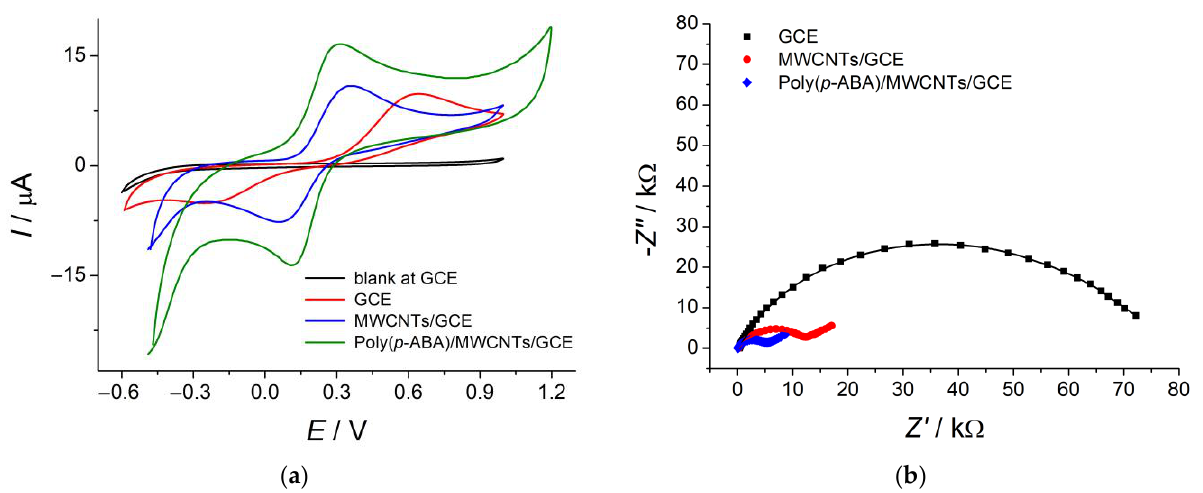
Figure 5. ( a ) Cyclic voltammograms of 1.0 mM ferrocyanide ions in 0.1 M KCl at the bare GCE, MWCNTs/GCE, and poly( p -ABA)/MWCNTs/GCE. The potential scan rate is 100 mV s ‒1 ; ( b ) Nyquist plot (experimental (points) and fitted (lines)) for bare GCE, MWCNTs/GCE, and poly( p - ABA)/MWCNTs/GCE in the presence of 1.0 mM mixture of ferro-/ferricyanide ions in 0.1 M KCl. Polarization potential is 0.21 V, frequency range is 10 kHz — 0.04 Hz, amplitude is 5 mV. An irreversible oxidation of the redox probe is observed at the bare GCE, which is in